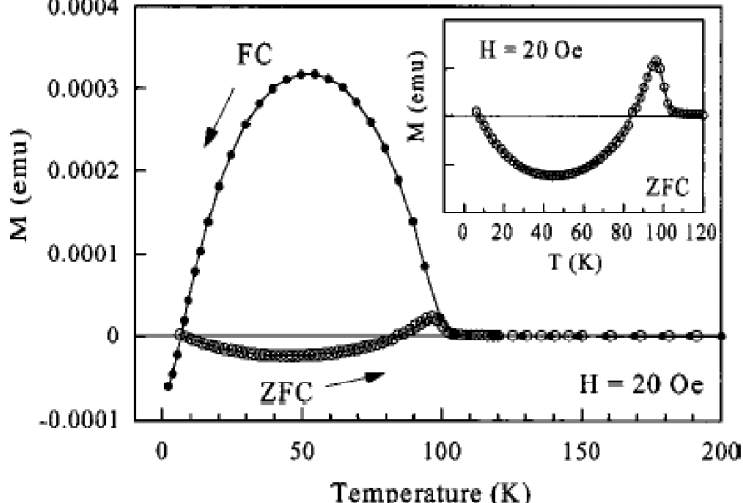
Fig. 10. Temperature dependent magnetization curves for the GCMO thin film under ZFC and FC condi- tions. The inset shows an magnifying part of figure. Reproduced from [65] with permission from WILEY-VCH Verlag GmbH & Co. KGaA.